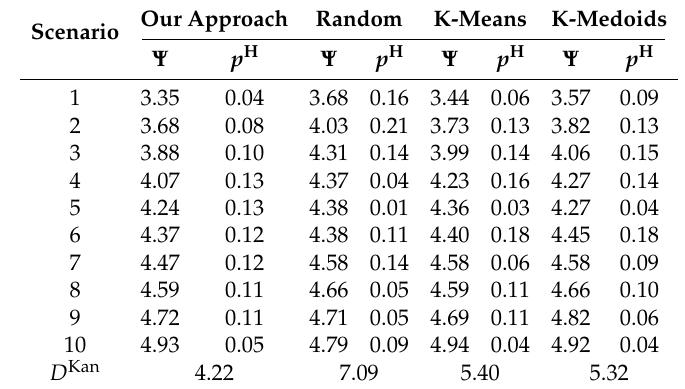
Table 5. Social welfare ( Ψ , in $10 15 ) and probability ( p H ) of 10 selected scenarios and the Kantorovich distance ( D Kan in $10 19 ) for Transmission Plan 2. The 10 selected scenarios for different approaches may be